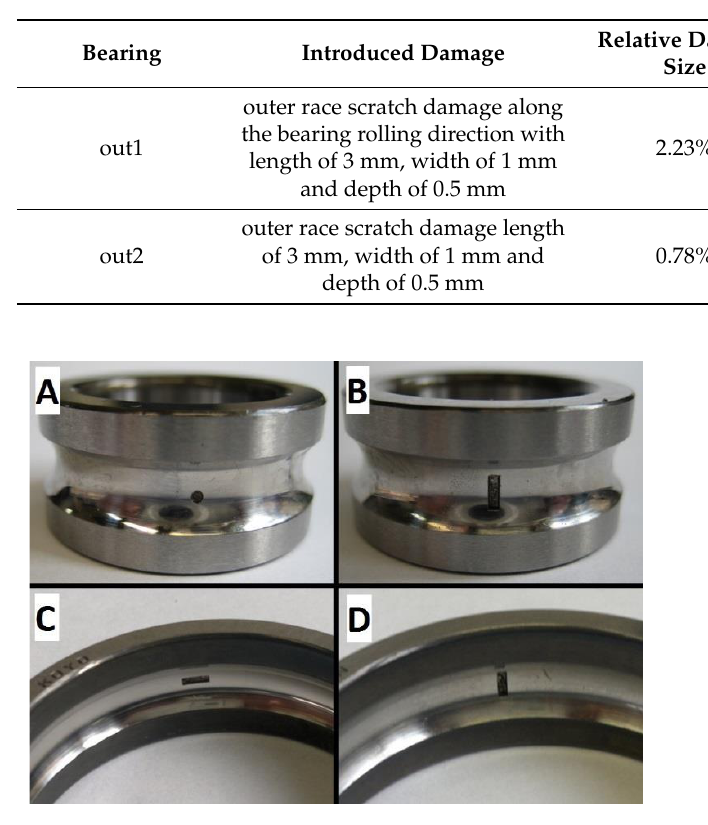
Figure 2. Close-up photos of the introduced bearing damage.